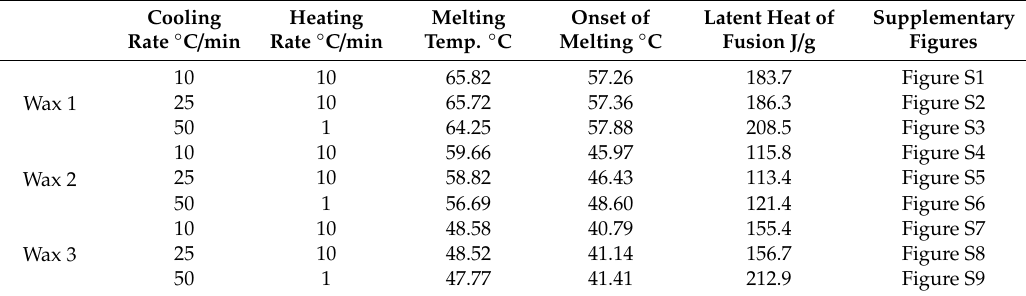
Table 1. Melting behaviour of waxes 1, 2 and 3 at various cooling and heating